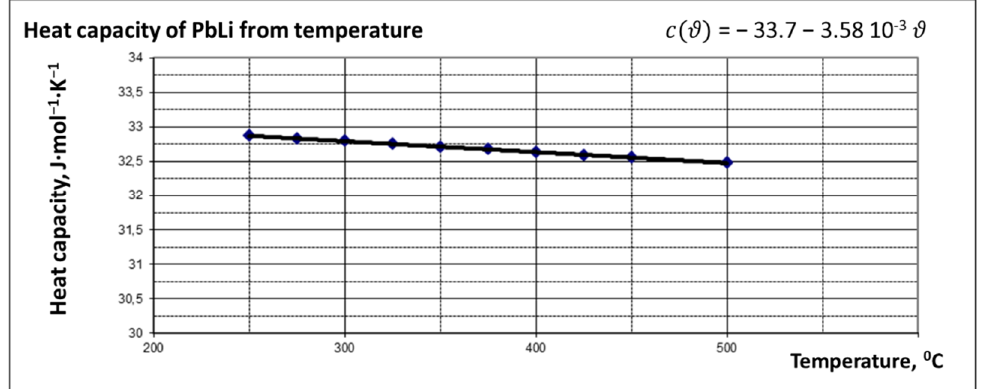
Figure 9. Dependence of heat capacity of PbLi on temperature.